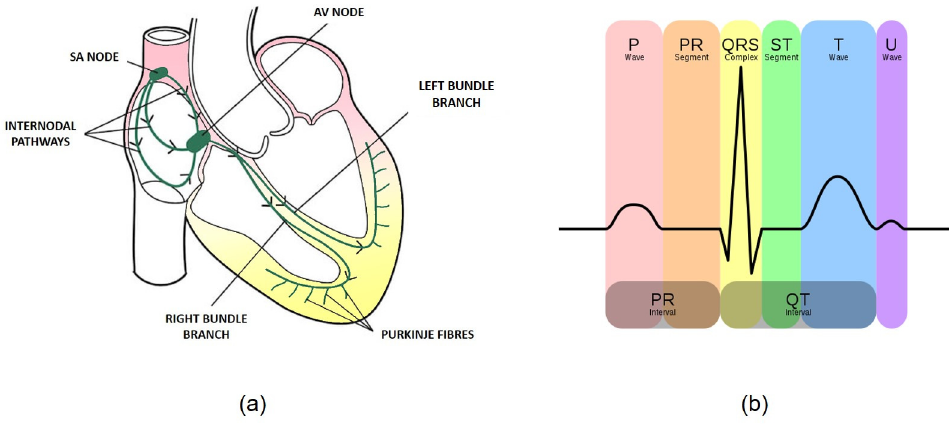
Figure 1. Electrophysiology of the heart ( a ) cardiac conduction system; ( b ) normal ECG